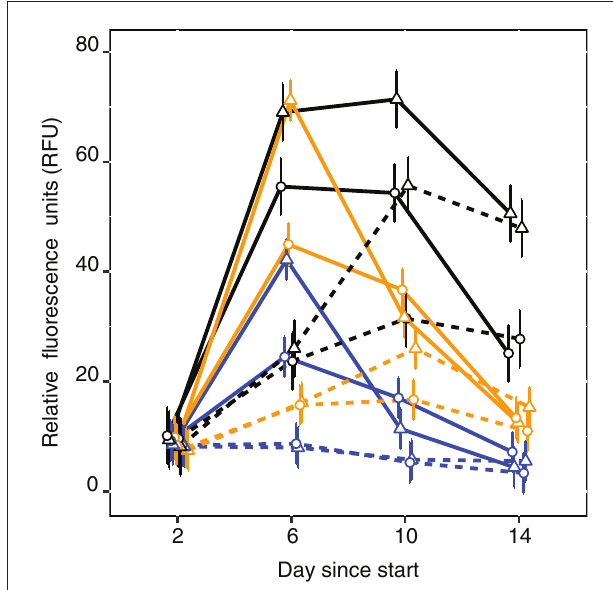
FIGURE 4 | Relative fluorescence units as proxy for algal biomass for the control (black), STHLM (orange) and GOR (blue) E. affinis populations. Solid and dotted lines are respective high and low nutrient treatments, triangles and circles are respective pelagic and benthic treatments. Estimates and 95% CI are fitted by restricted maximum